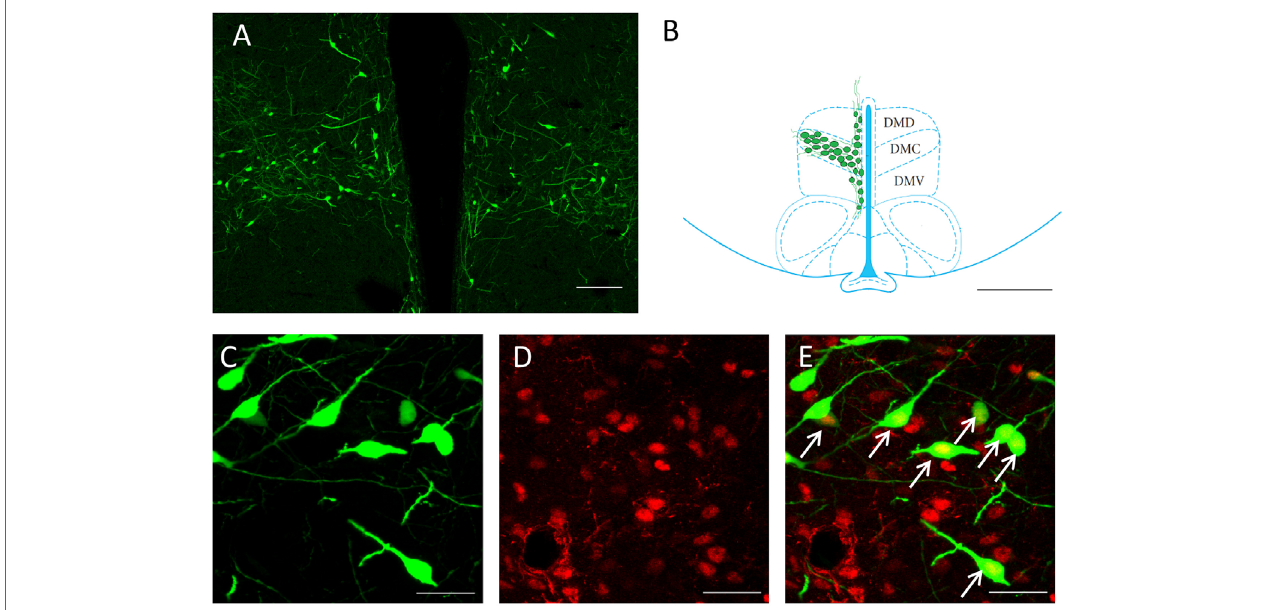
FigUre 1 | Expression of CLOCK protein within GnIH neurons in the DMH region. (a) An overview of GnIH-expressing neurons in the DMH at 10 × magnification. (B) Primary area of GnIH neuron expression mapped out on the rat brain atlas. Bregma of image is at − 3.12 mm. Sectioned areas were taken from a bregma of − 0.26 to − 4.16 mm. Scale bar = 100 µm (a) and 200 µm (B) . (c) EGFP-GnIH-expressing neurons (green), (D) CLOCK-immunostained neurons (red), and (e) combined EGFP-GnIH (green) and CLOCK (red) images at 40 × magnification. Scale bar = 20 µm (c–e) . White arrows indicate the presence of CLOCK localization. DMC, dorsomedial hypothalamic nucleus, compact; DMD, dorsomedial hypothalamic nucleus, dorsal; DMV, dorsomedial hypothalamic nucleus; ventral; GnIH, gonadotropin-inhibitory hormone; DMH, dorsomedial